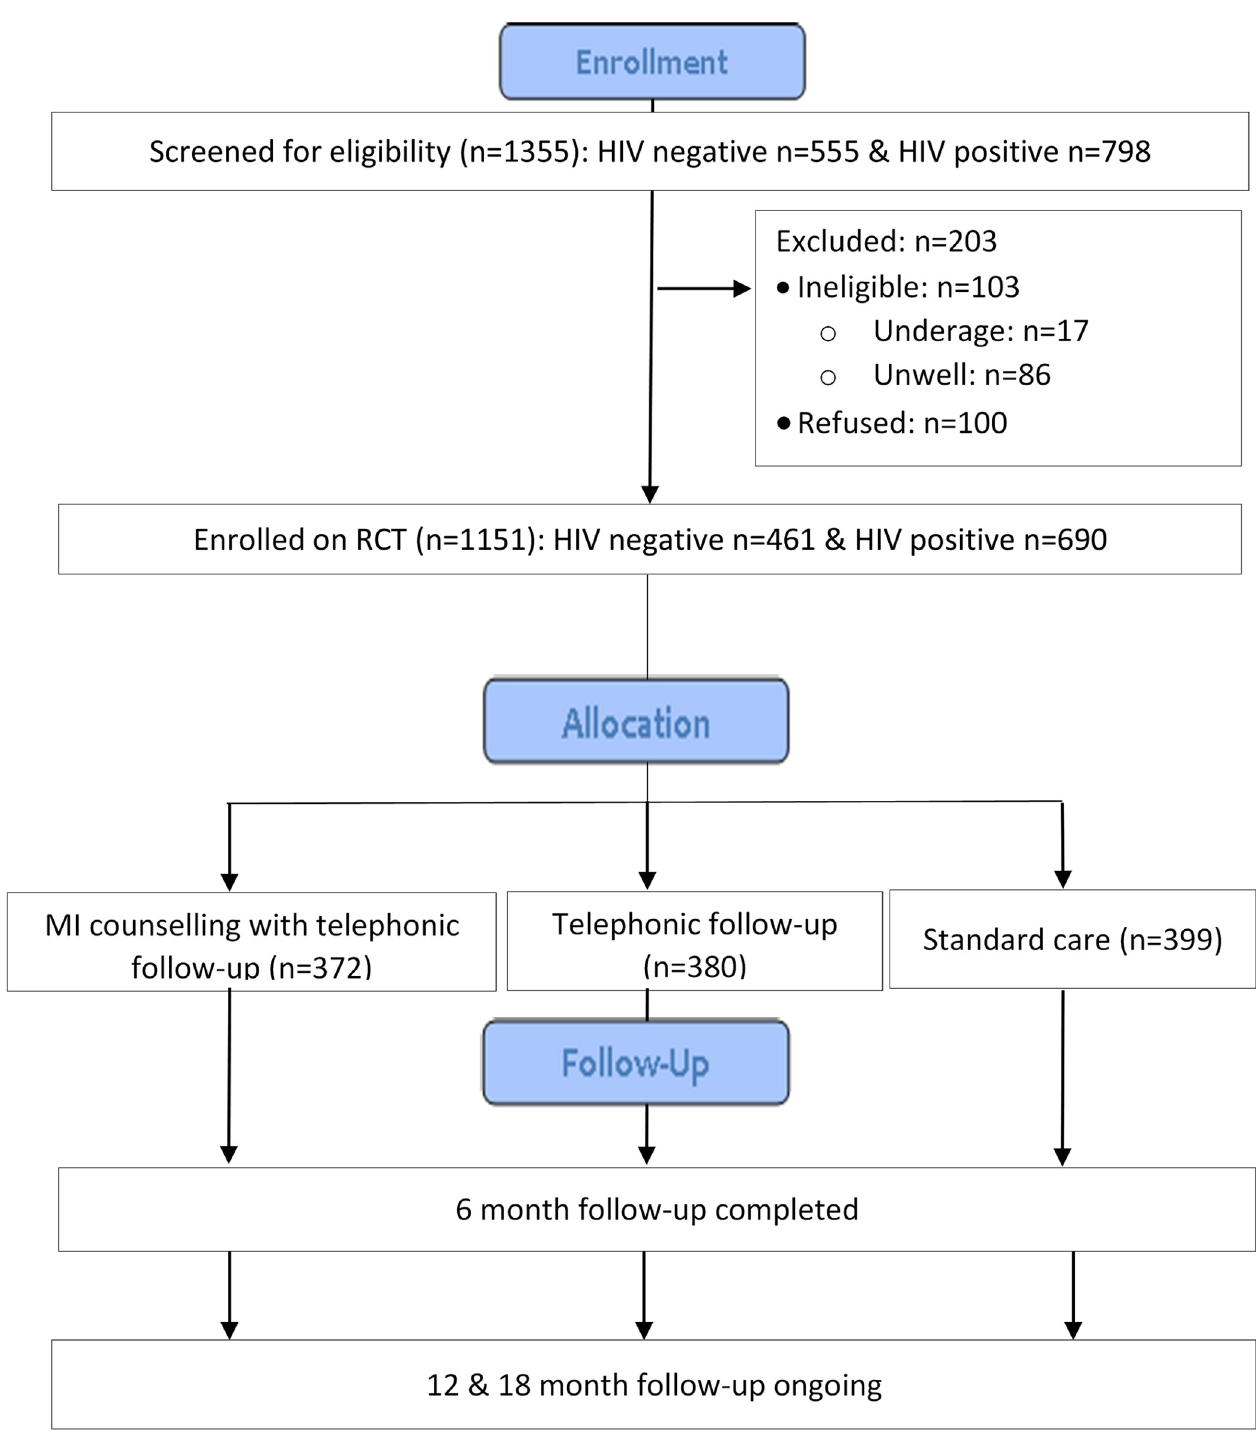
Fig 1. CONSORT diagram of participant enrolment and follow-up in the parent study (RCT).